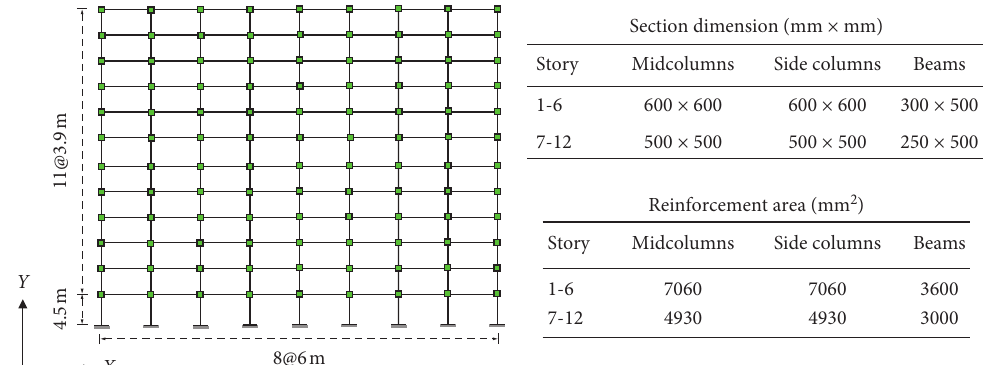
Figure 6: Elevation view and section information.